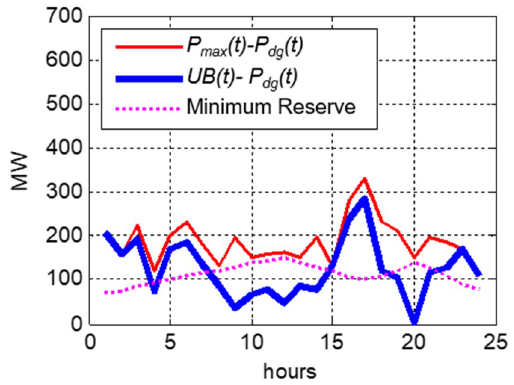
Figure 5. Conventional reserve and feasible reserve of the deterministic case 1. 284